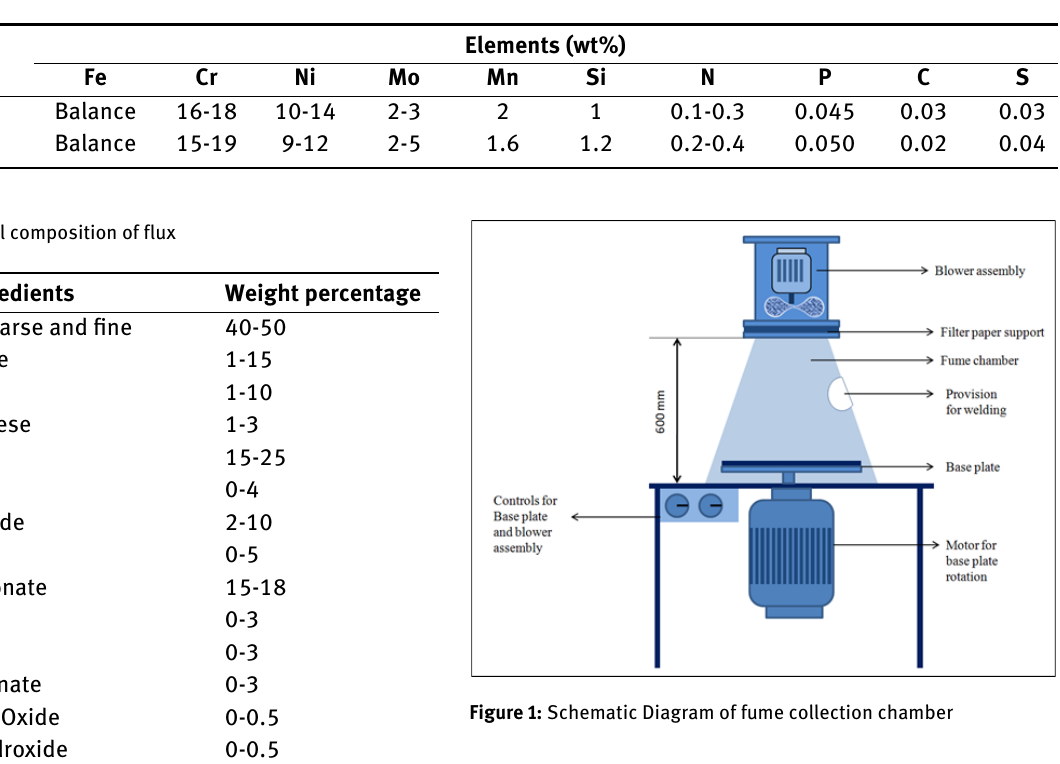
Table 1: Chemical composition of base metal and Core wire